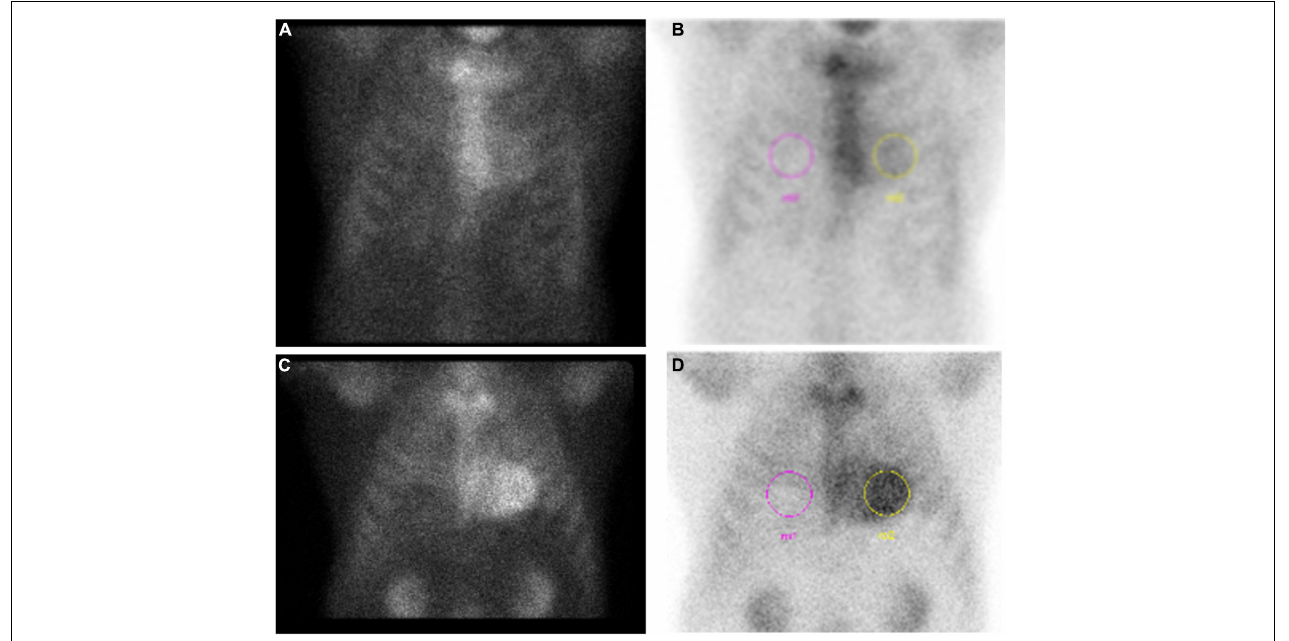
FIGURE 6 | Example results of pyrophosphate (PYP) scan in two patients diagnosed with ATTR-CA. (A) Grade 1 (negative) scan with (B) H/CL = 1.4 in a patient later diagnosed by endomyocardial biopsy. (C) Grade 3 (positive) PYP scan with (D) H/CL =